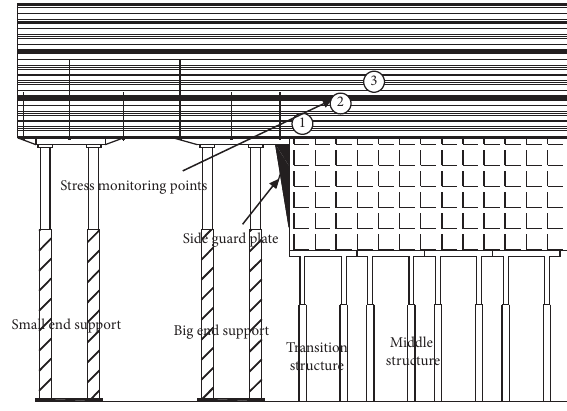
Figure 8: Distribution of measuring